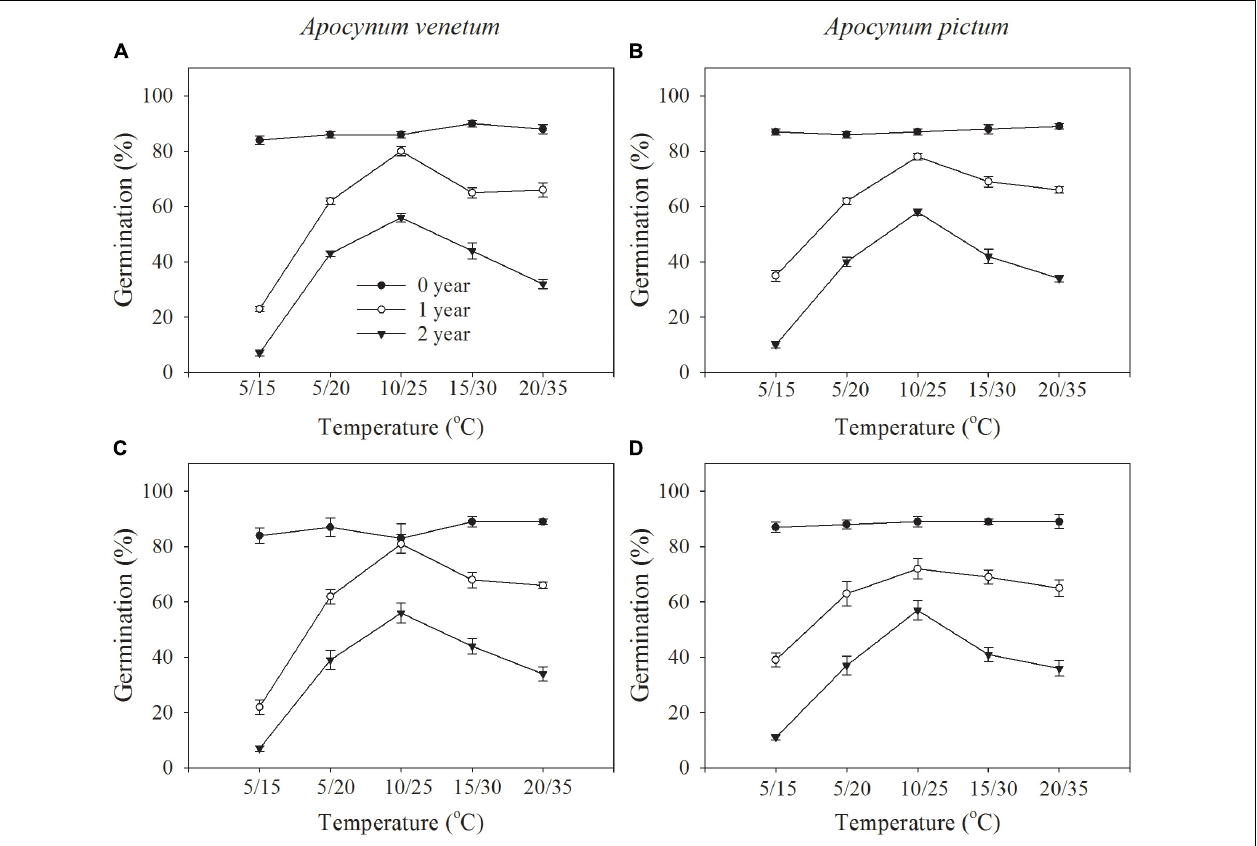
FIGURE 1 | Germination responses of Apocynum venetum and Apocynum pictum seeds stored for 0, 1, and 2 years to 12-h darkness/12-h light (A,B) or 24-h darkness (C,D) under different temperatures.